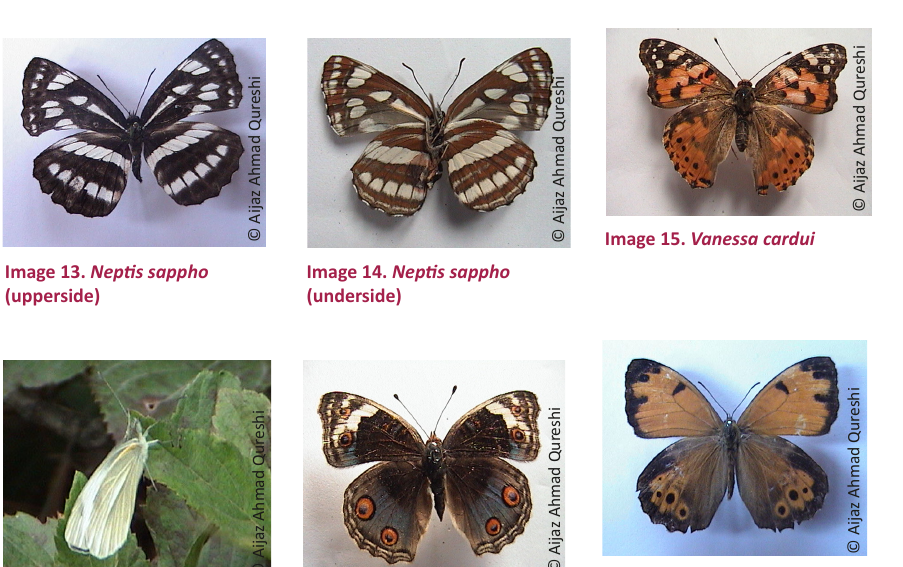
Image 20. Parage eversmanni cashmirensis